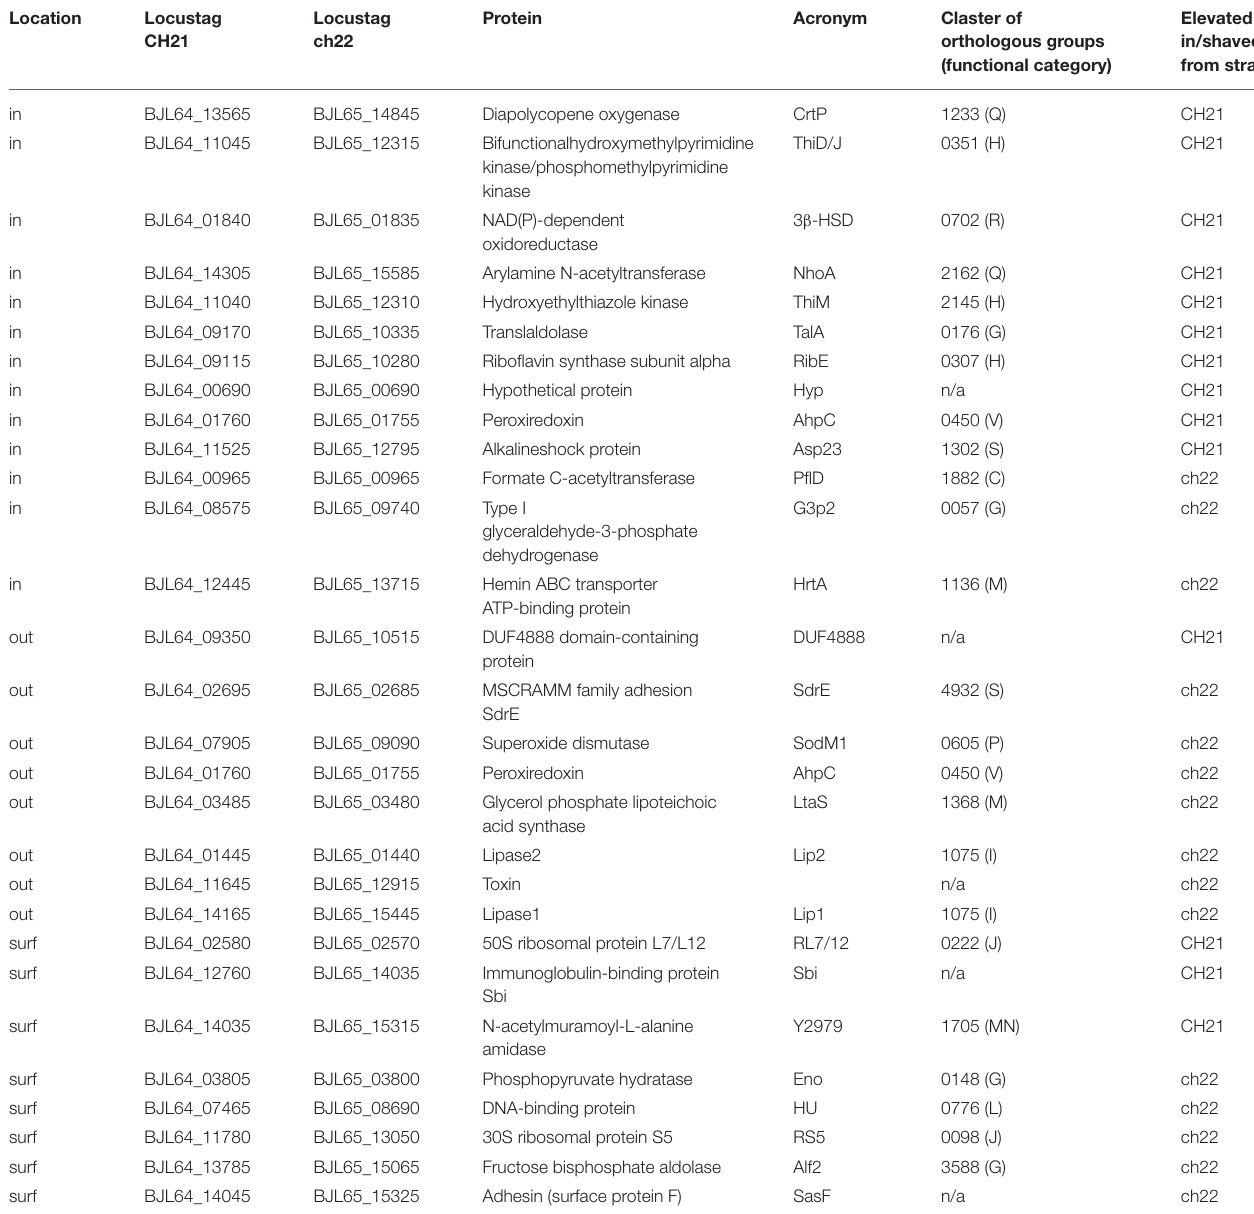
TABLE 5 | List of proteins differentially expressed by VIR CH21 and NVIR ch22 strains as identified by proteomics.